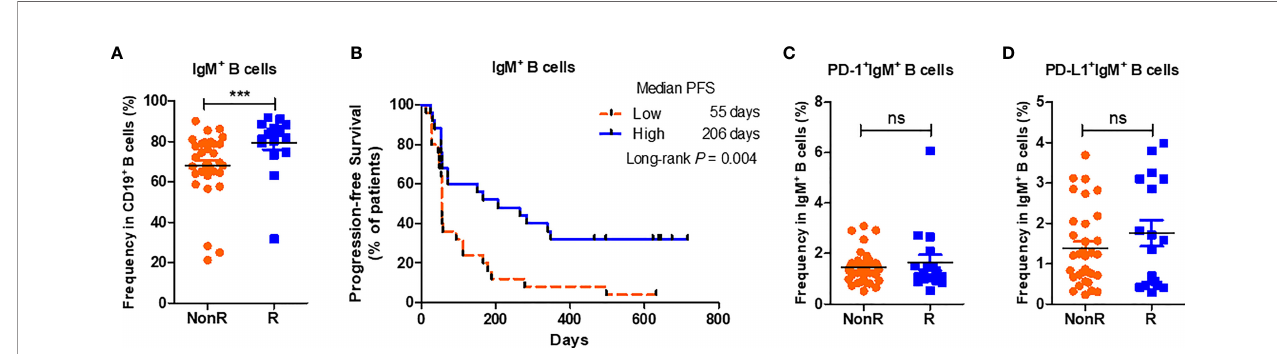
FIGURE 2 | High percentages of IgM positive cells in B cells at the baseline facilitate the response to anti-PD-1 treatment. (A) Comparison of the percentages of IgM + B cells between R (n = 17) and NonR (n = 33) NSCLC patients receiving anti-PD-1 monotherapy at the baseline. (B) Kaplan-Meier analysis of the associations of the percentages of IgM + B cells with the PFS values. (C, D) Comparison of the frequencies of PD-1 + IgM + B cells (C) and PD-L1 + IgM + B cells (D) between R (n = 17) and NonR (n = 33) NSCLC patients at the baseline. The Wilcoxon test was used to analyze the differences between two groups. Survival curves were plotted by using the Kaplan-Meier method with the median as the cutoff to de fi ne the high and low group. P -values were calculated by the log-rank statistics in Kaplan-Meier analyses. *** P < 0.001, ns, P